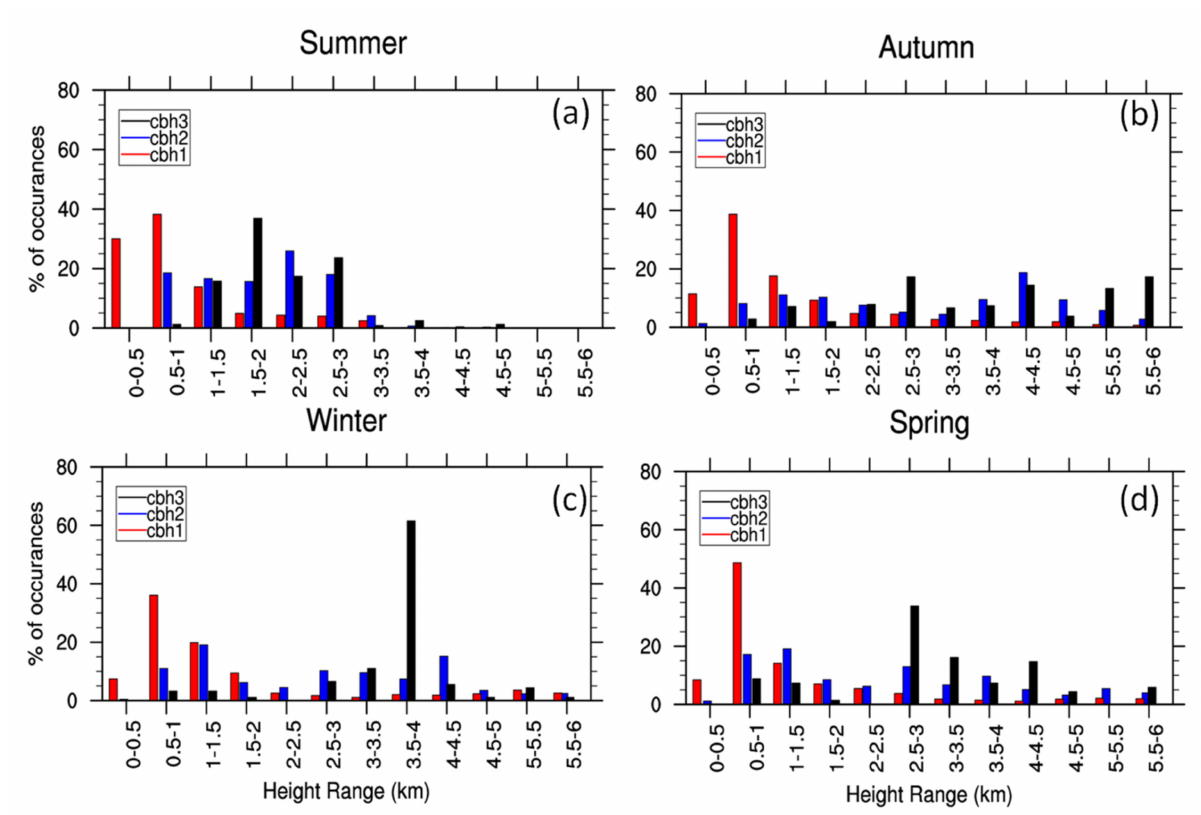
Figure 6. Height distributions of three cloud bases detected by ceilometer for June 2017 (Summer), October 2015 and 2017 (Autumn), January 2016 (Winter), April 2016 and 2017 (Spring). The Y-axis shows the percentage of occurrences at different height ranges shown in X axis.